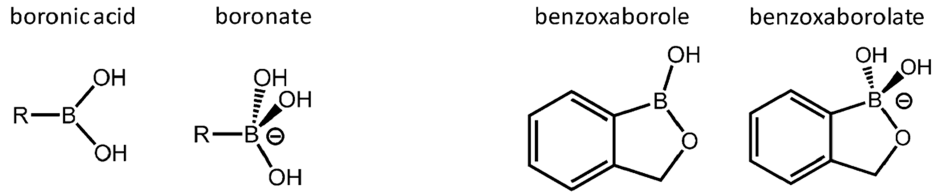
Figure 4. Representation of the structures of boronic acid/boronate (left); and benzoxaborole/benzoxaborolate (right). Only the tetrahedral-boron forms of boronate/benzoxaborolate anions are shown here. Adapted from reference [17]. Reproduced with permission from reference [17], published by MDPI, 2016.